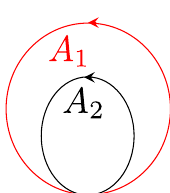
Figure 8. The definition of the intersecting Wilson loop with areas A 1 and A 2 . A 1 is the area inside the outer loop while A 2 is the area inside the inner